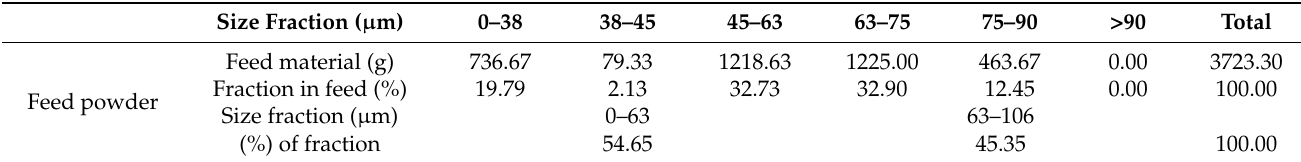
Table 1. Particle size distribution of the feed powder for the bulk test.